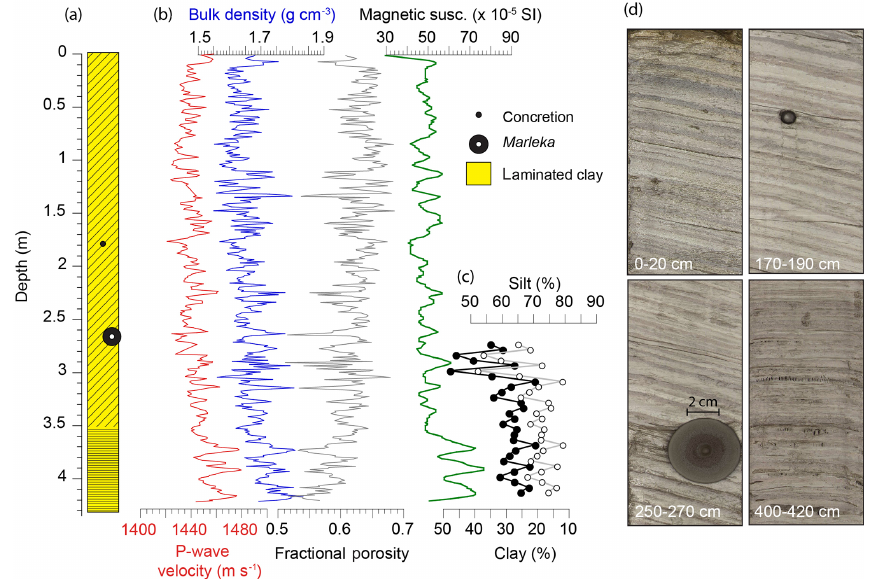
Figure 7. Lithology and sedimentology of sediment core Asko2018HT-2GC. Image includes a lithologic log (a) , sediment physical properties measured on the MSCL (b) , and results from grain size analyses showing variations in clay and silt content across the zone where the overall porosity reduction is seen ( ∼ 3 . 5m) (c) . Characteristic images from four different depths are shown (d) , including the 2cm diameter concretion recovered at 2.64m and the smaller concretion at